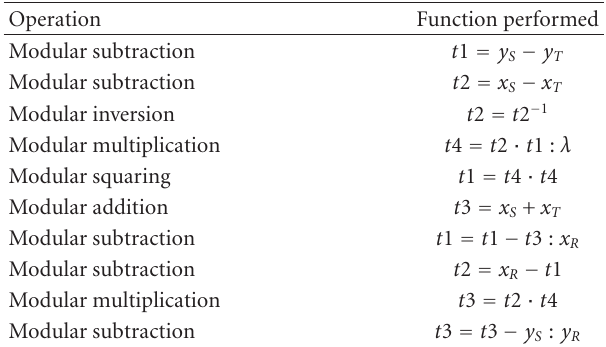
Table 1: Arithmetic operations for point addition: S + T = R